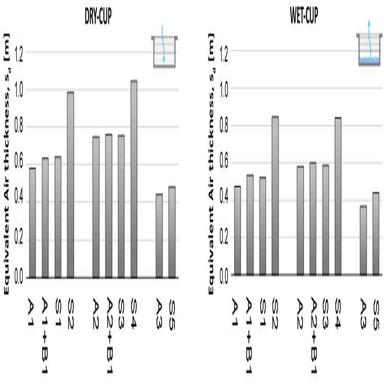
Resistance to water vapour diffusion, experimental results.